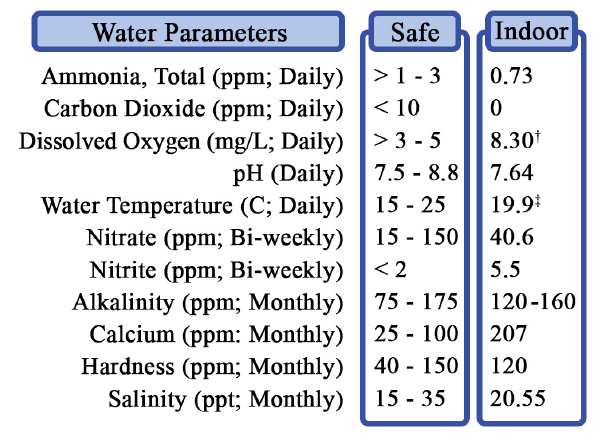
FIGURE 3 | RAS water quality parameters and testing. Measurements were performed daily, weekly, biweekly, or monthly, as indicated. † Average dissolved oxygen range: 6.3–11.1 mg/L. ‡ Average temperature range: 17.1–21.7 ◦ C.